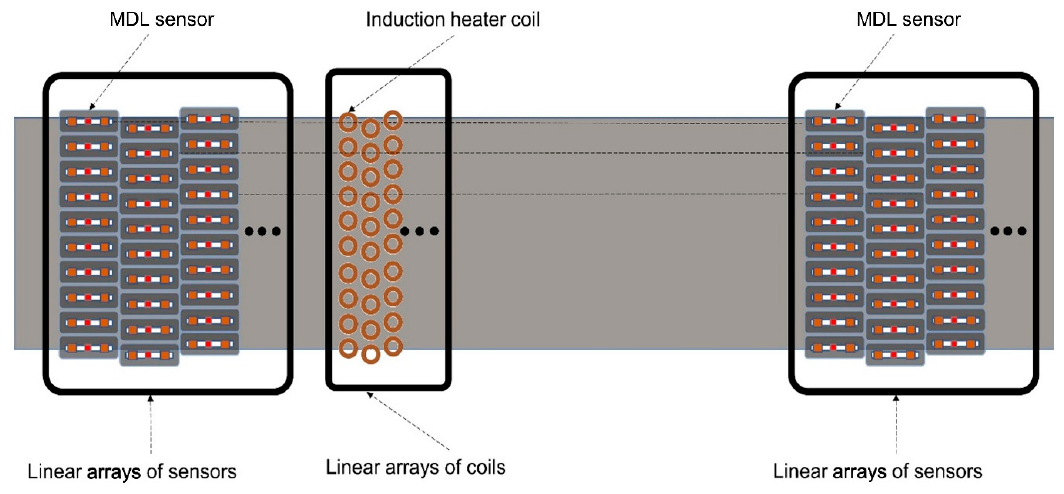
Figure 9. A stress monitoring and annihilation system based on localized stress.